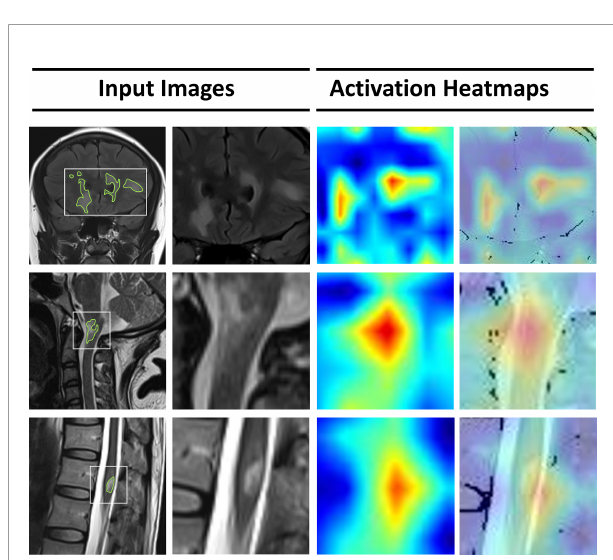
FIGURE 4 | Visualization of features extracted by the deep-learning model from the input images. From the left, the fi rst column represents the original MRI slices with manual annotations of lesions in the brain, cervical spinal cord, and thoracic spinal cord. In the second column, a smaller patch is cropped around the lesions. The third column represents the activation heatmaps. The color depth of the heatmaps represents the possibility of predicted lesions by the model. The fourth column overlaps the activation mapping with the original MRI for better visual